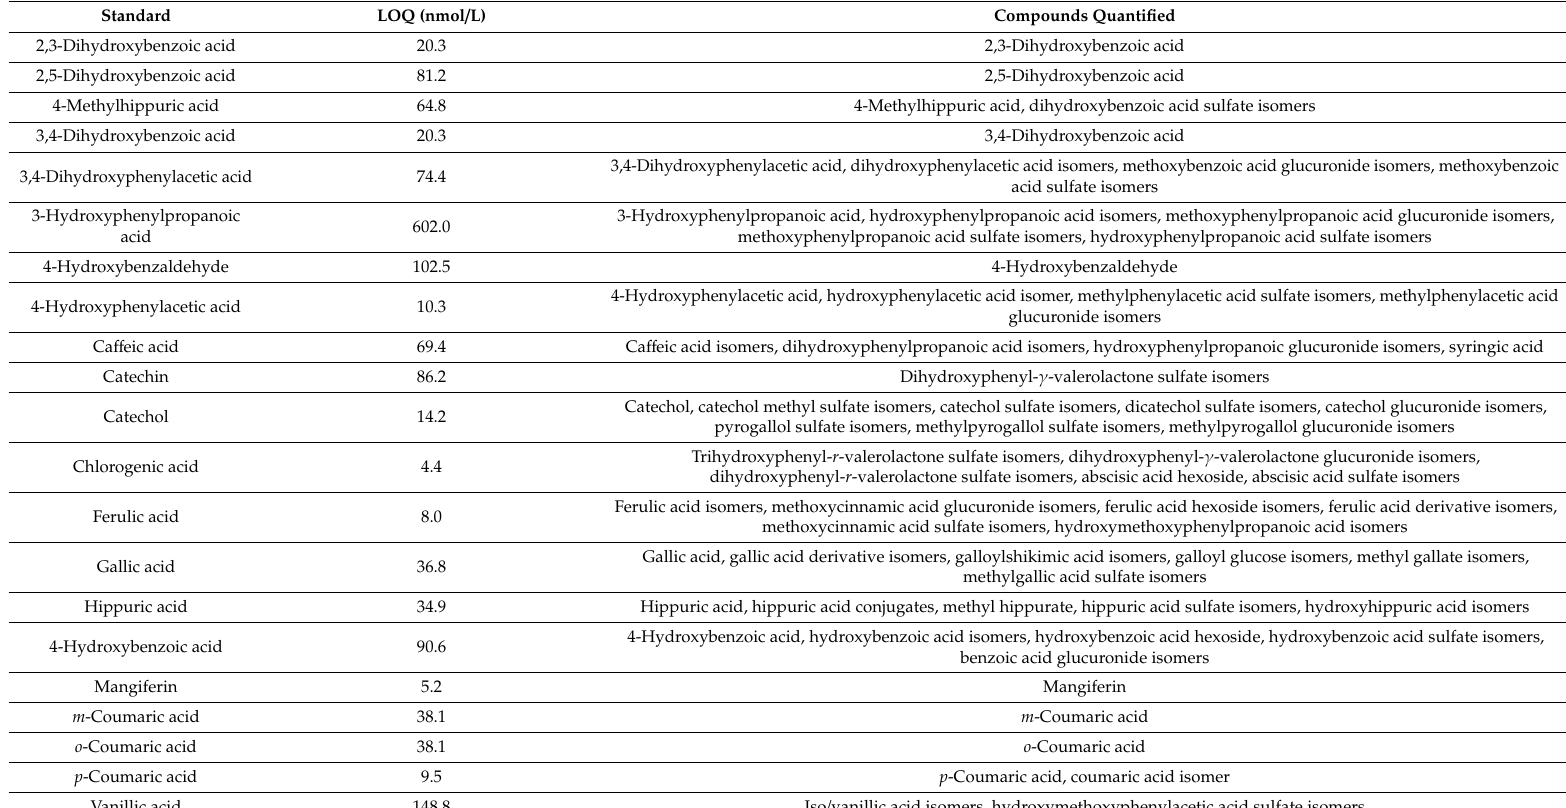
Table A4. Standards used for the quantification of (poly)phenolic metabolites with their limits of quantification